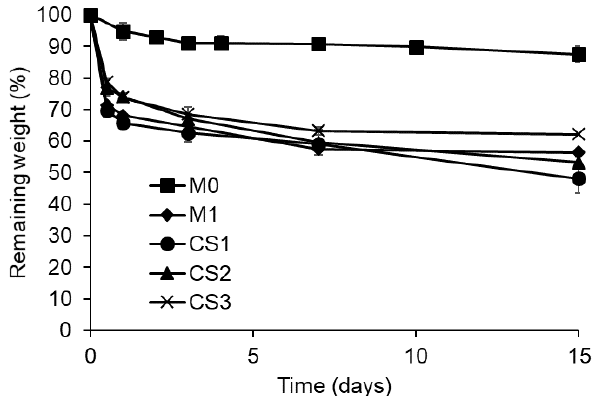
Figure 4. Weight loss at pH 7.4 at 37 °C within 15 days of degradation of monolithic and core-sheath